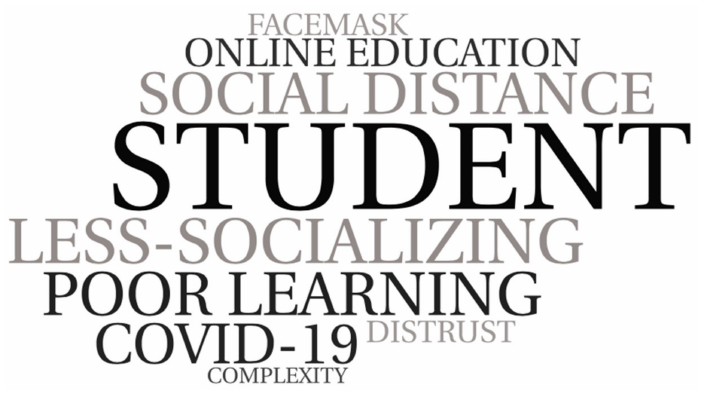
Figure 3. World cloud alluding to arguments in relation to students. Self-made